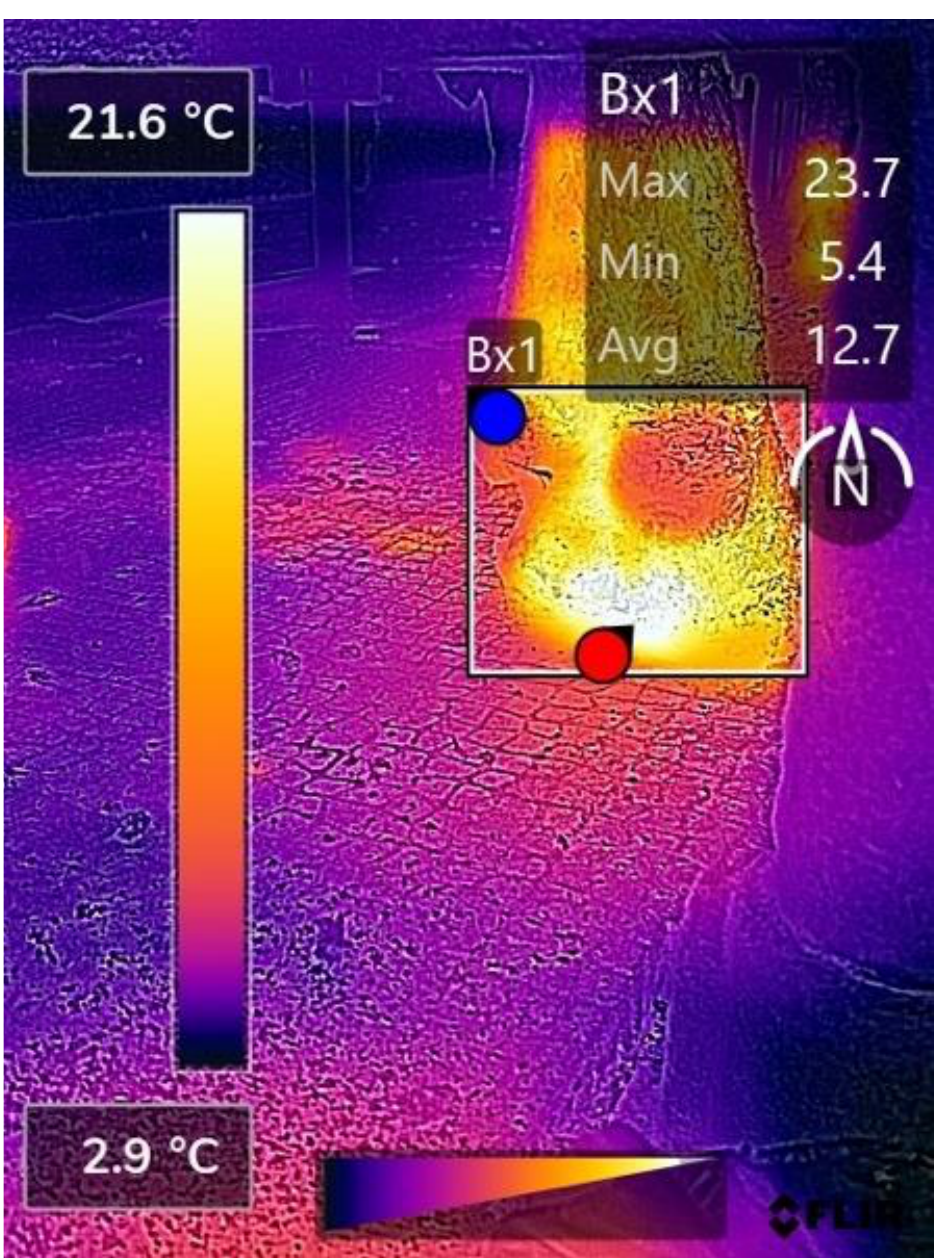
Figure A1. A thermogram, obtained by the CAT s62-Pro Smartphone (LCD), of cattle diagnosed with digital dermatitis on routine foot trimming, displaying a pattern of heat with maximum intensity over the interdigital space, rather than between the heel bulbs.